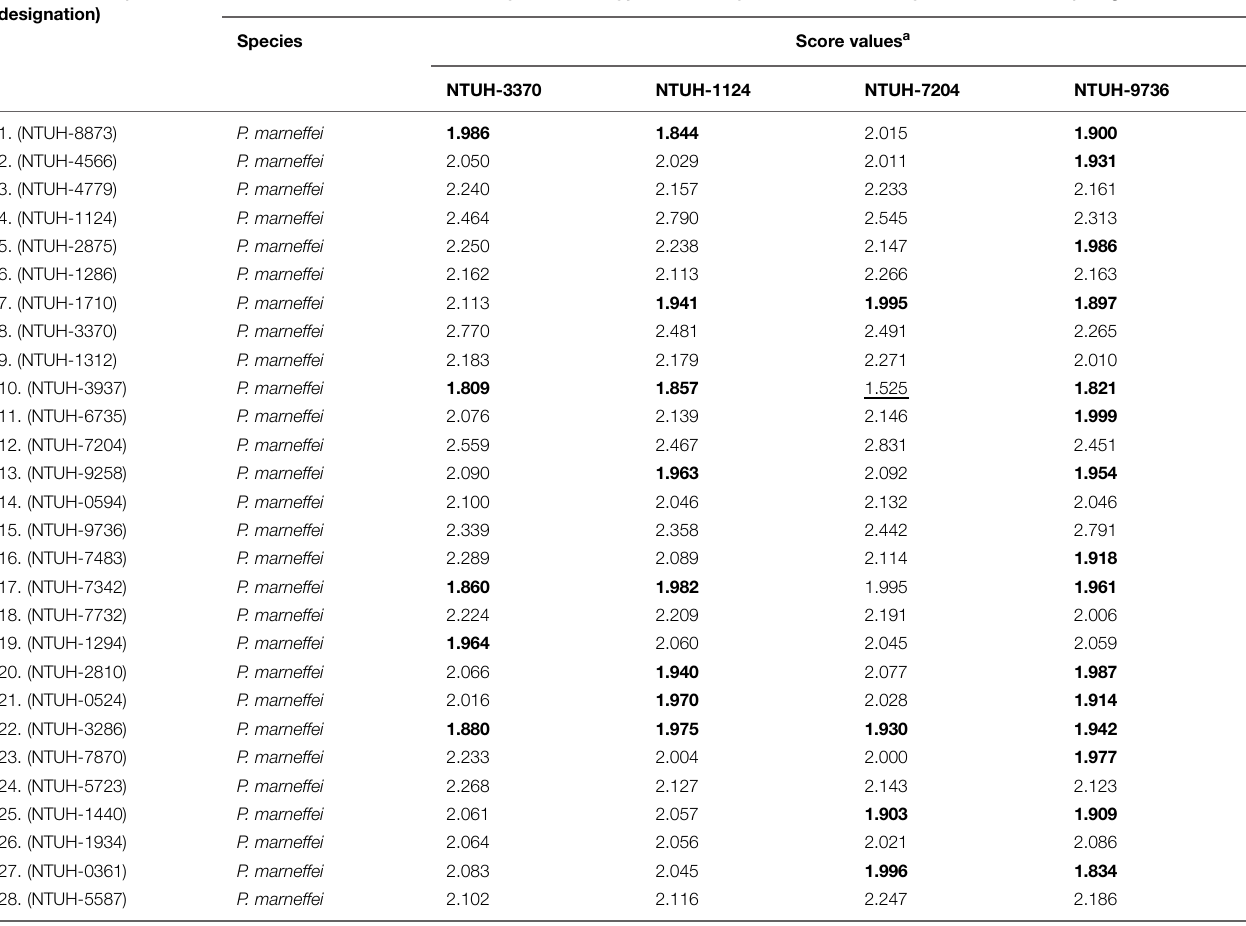
TABLE 3 | Identification results of the 28 isolates of P. marneffei by MALDI Biotyper based on four newly created databases for P. marneffei. No. of Isolates (strain Identification and score values by MALDI Biotyper with newly created database by indicated strains (designation of cluster) designation)